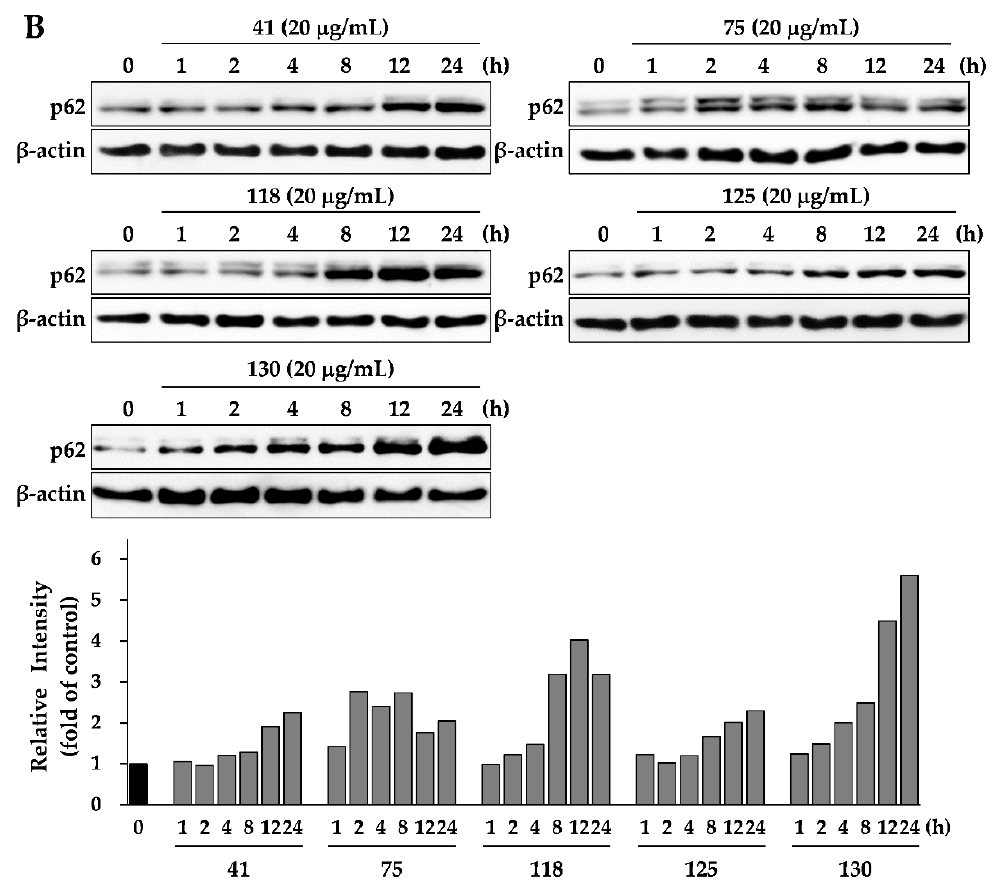
Figure 3. E ff ects of eight crude extracts on p62 expression in HepG2 cells. Cells were treated with each crude extract at the indicated concentrations and for di ff erent durations. The expressions levels of p62 and β -actin were determined by Western blotting. ( A ) The e ff ect of crude extracts on cell viability. ( B ) The e ff ect of crude extracts that suppressed cell viability. The data shown are representative of three independent treatments using the same parameters with similar